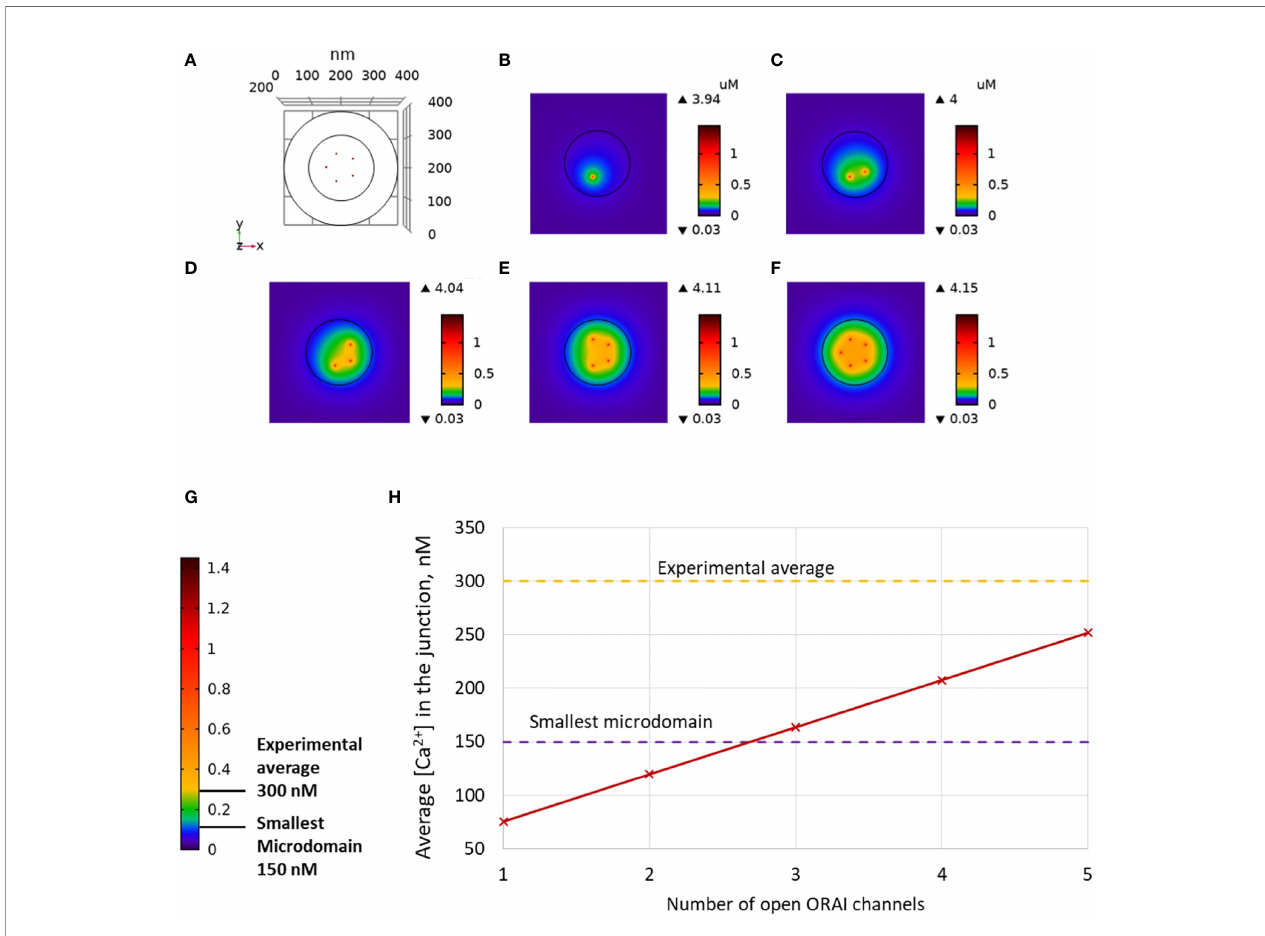
FIGURE 2 | Simulated Ca 2+ microdomains resulting from the opening of ORAI1 channels under the conditions of a full ER. (A) Upper view of the arrangement of the ORAI1 channels on the PM of the junction using COMSOL. (B – F) Steady-state Ca 2+ pro fi les in the junction when opening 1 (B) to 5 (F) ORAI1 channels simultaneously. Left bars indicate the color codes, together with the minimal and maximal concentrations reached in the related panels. Shown are the pro fi les 22ms after opening of the ORAI1s, but these stabilize very rapidly, after a few ms. (G) Extended color code with marking of the smallest amplitude experimentally considered to correspond to a microdomain and of the average amplitude of microdomain in unstimulated T cells (4). (H) Evolution of the amplitude of the simulated Ca 2+ microdomains with the number of simultaneously open ORAI1 in the junction, showing that experimentally observed microdomains cannot result from the sole opening of the ORAI1 in conditions of a full ER that only allows for a partial opening of these channels (see